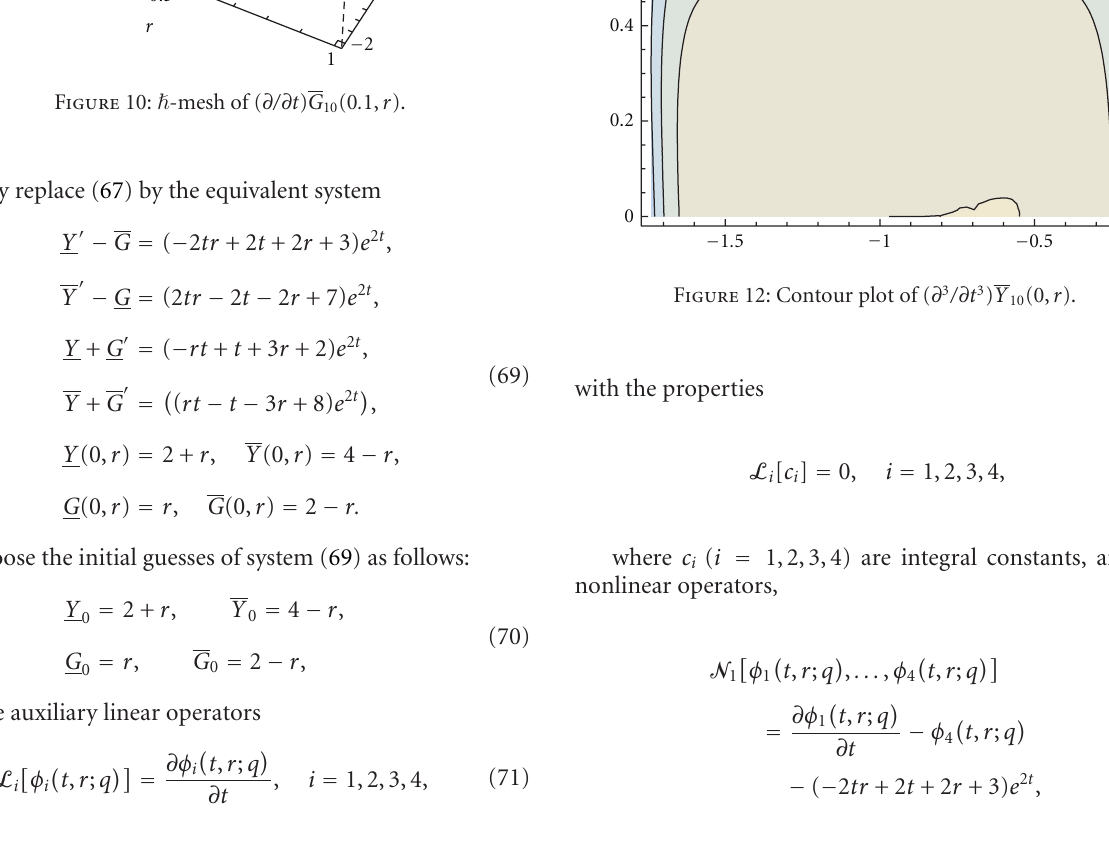
Figure 10: (cid:2) -mesh of ( ∂/∂t ) G 10 (0 . 1, r ).